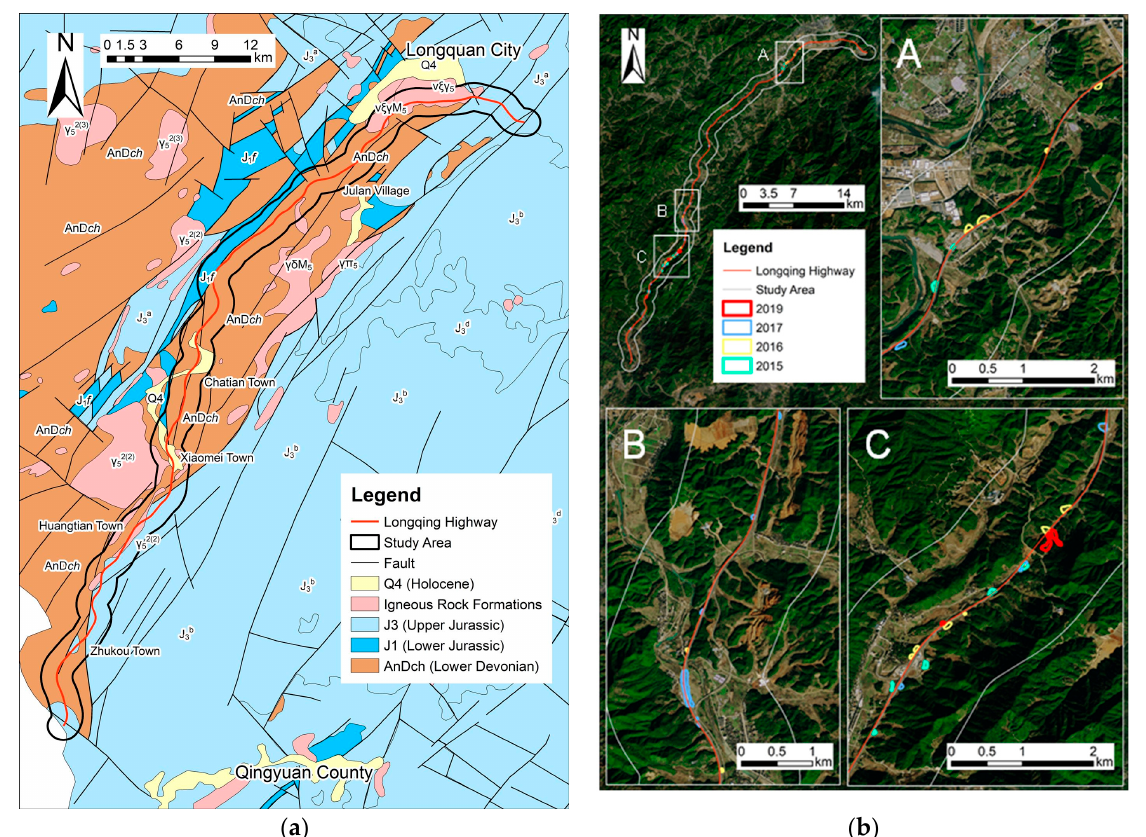
Figure 2. ( a ) Geology map for the study area; ( b ) historical slope hazard records within the study area.